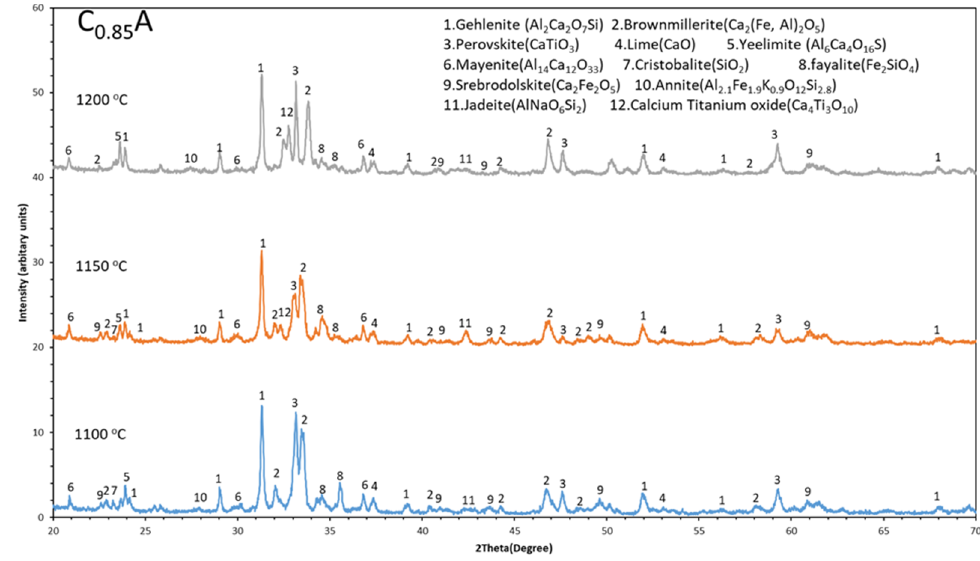
Figure 7. XRD patterns of the C 0.85 A oxide pellets at different sintering temperatures.